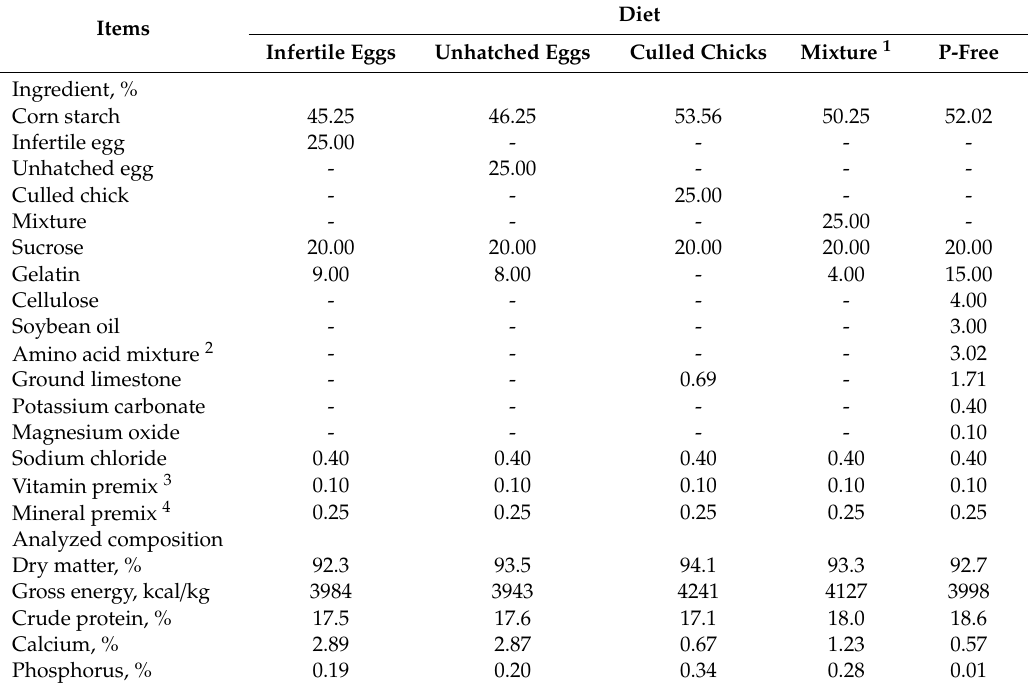
Table 2. Ingredients and chemical compositions of the experimental diets (as-fed basis) in Experiment